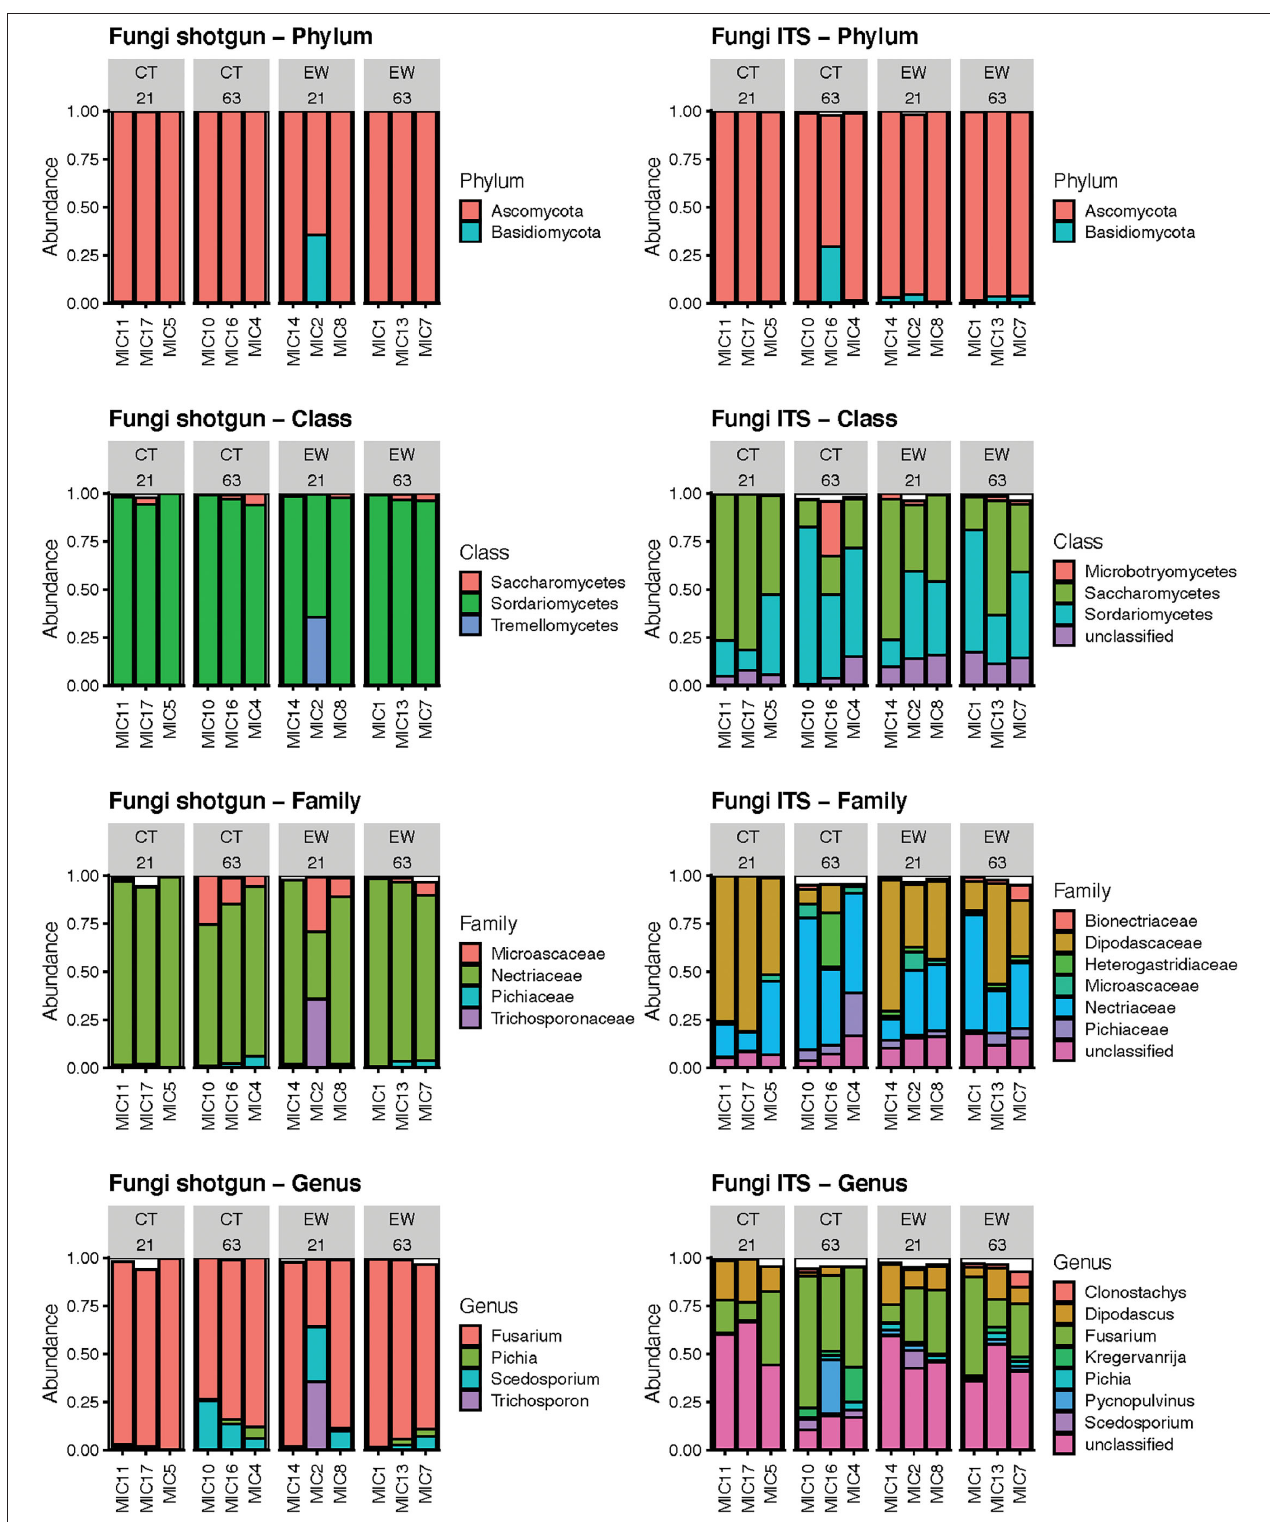
FIGURE 5 | Bar plots of the mean relative abundance of the predominant fungi by phylum, class, family and genus using shotgun reads and ITS ASVs in 12 microcosms (MIC). The white section of the bar plots represents the less abundant taxa compiled.